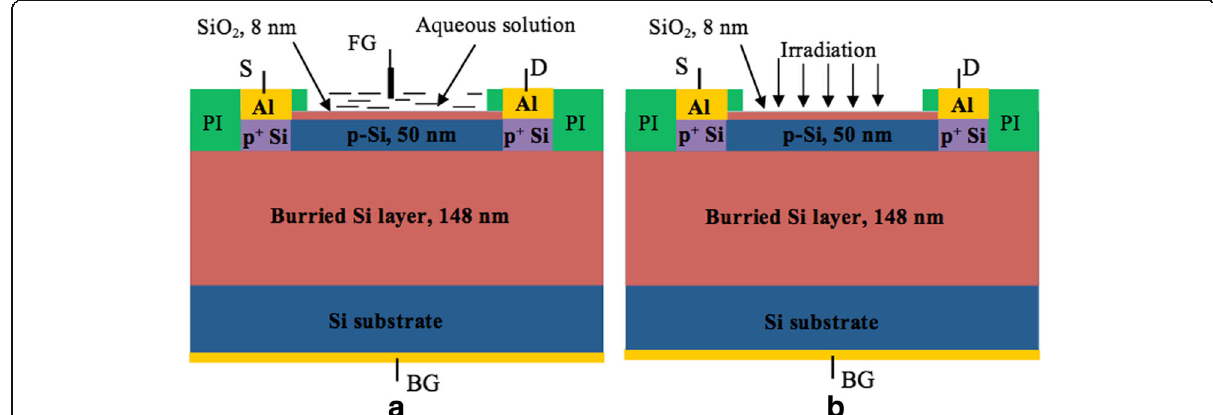
Fig. 1 Si nanowire field-effect transistor structures under study. Schematic picture of the samples under study: pH — sensor operating mode ( a ) and